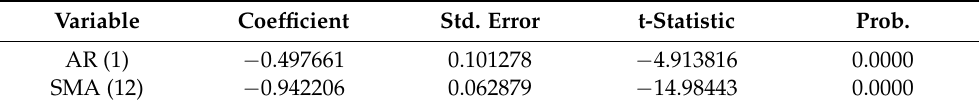
Table 8. GARCH test. Table 7. Estimation of the SARIMA model.